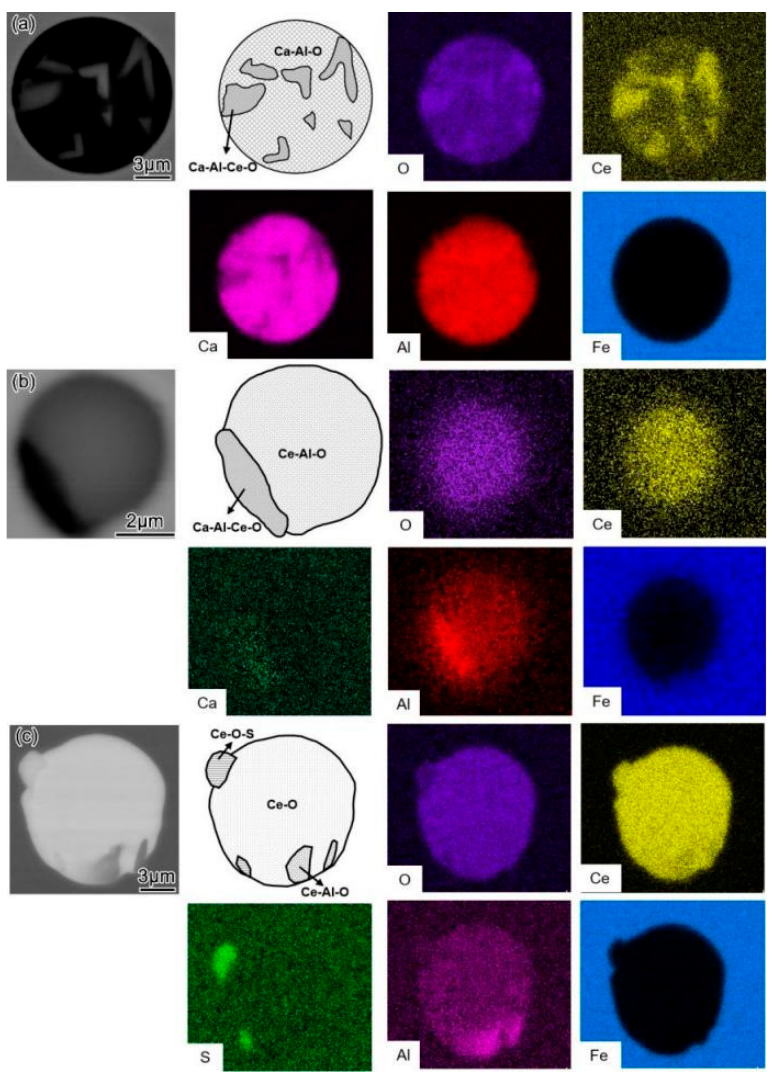
Figure 5. Morphology of typical inclusions in steel after reaction with Ce for 5 min (T2): ( a ) L–Ce;